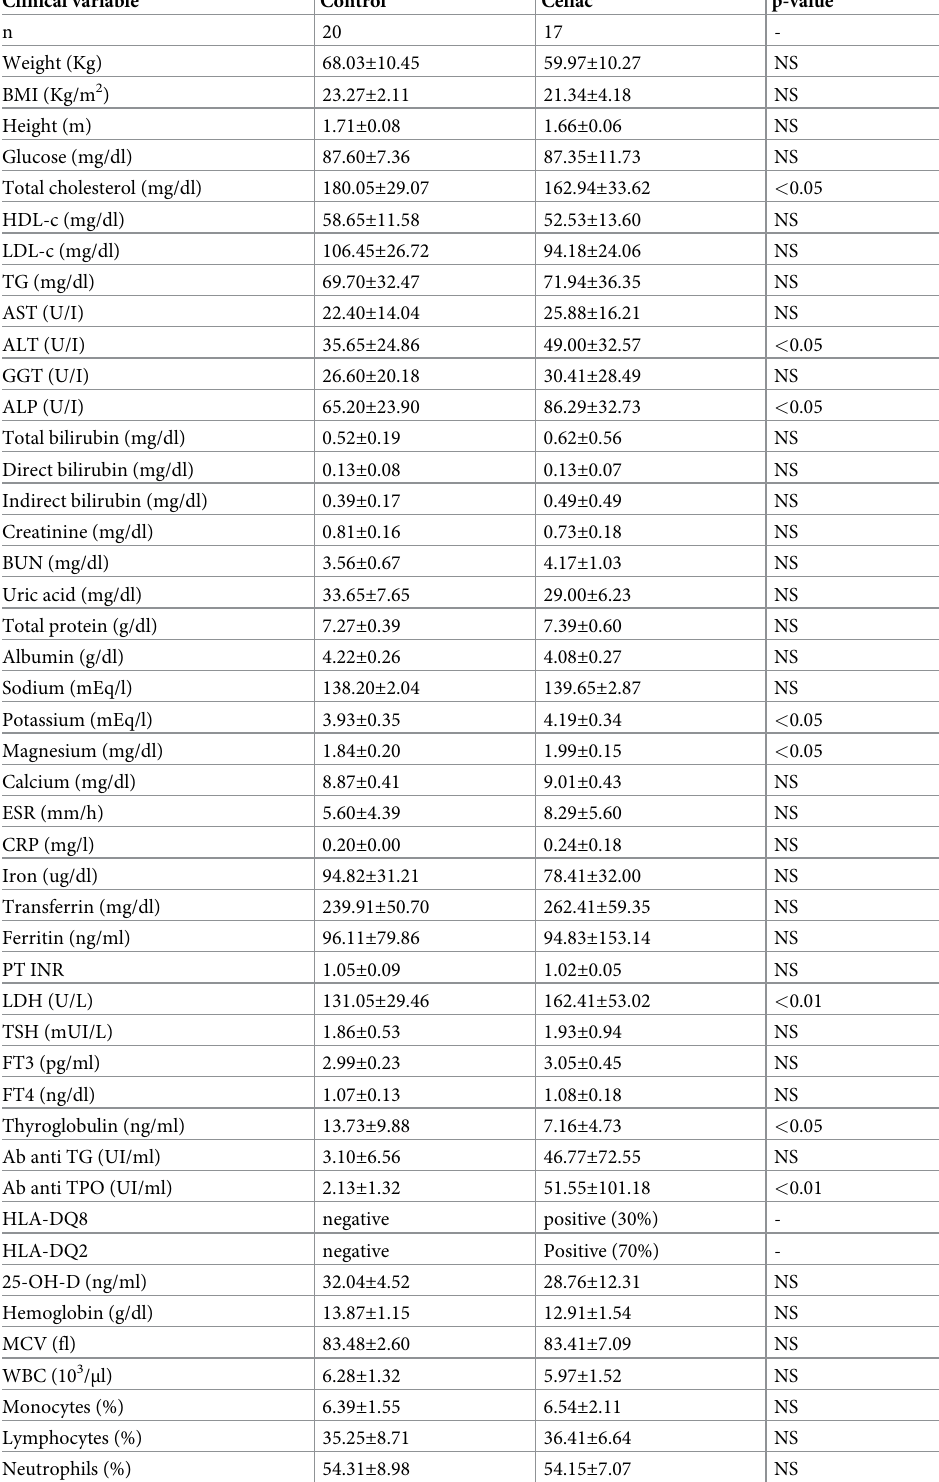
Table 2. Clinical characterization of the study